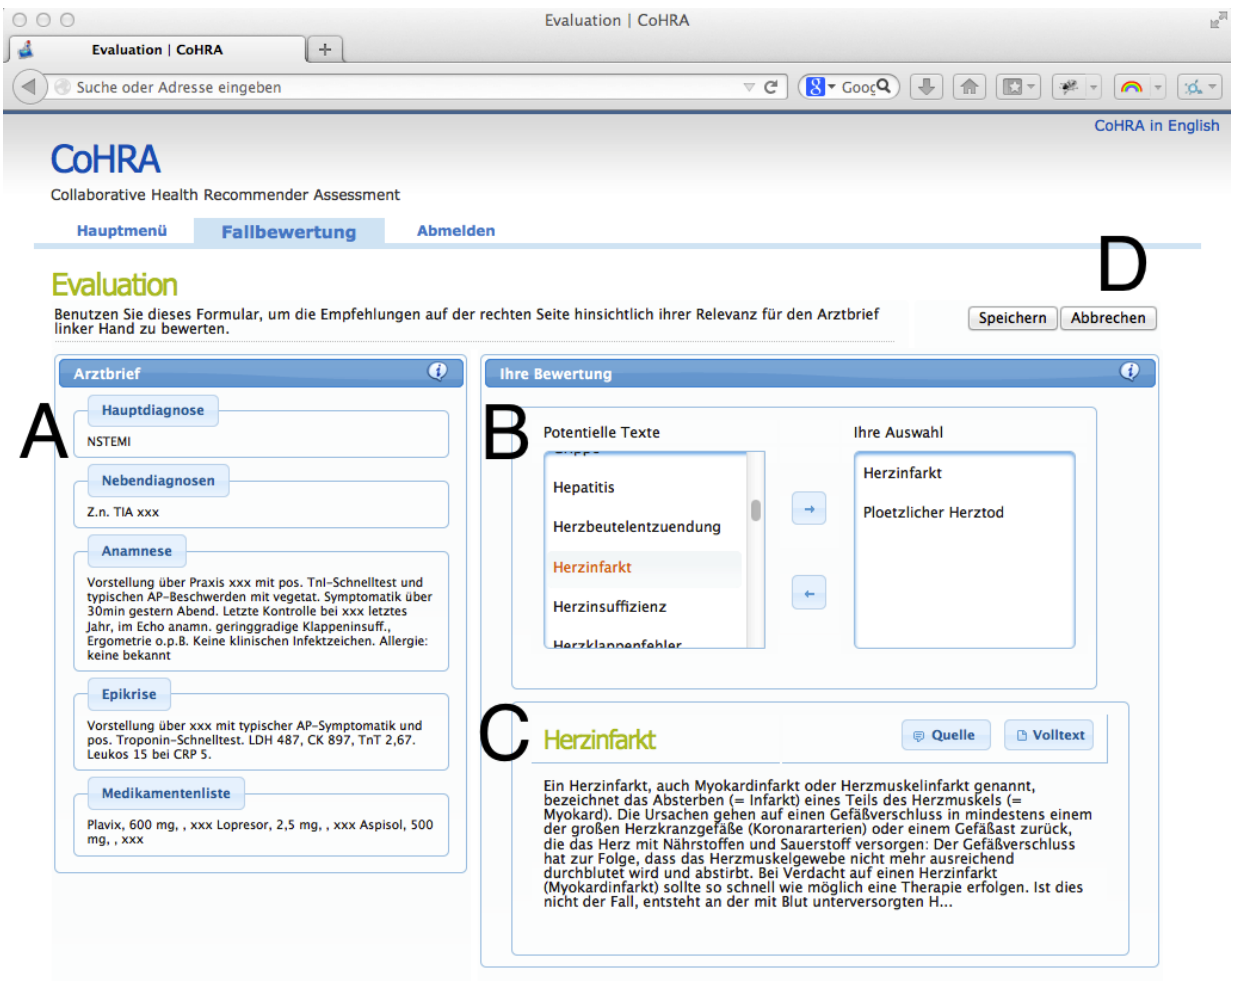
Figure 4. The main view of our HRS assessment system. Health professionals select matching items based on their